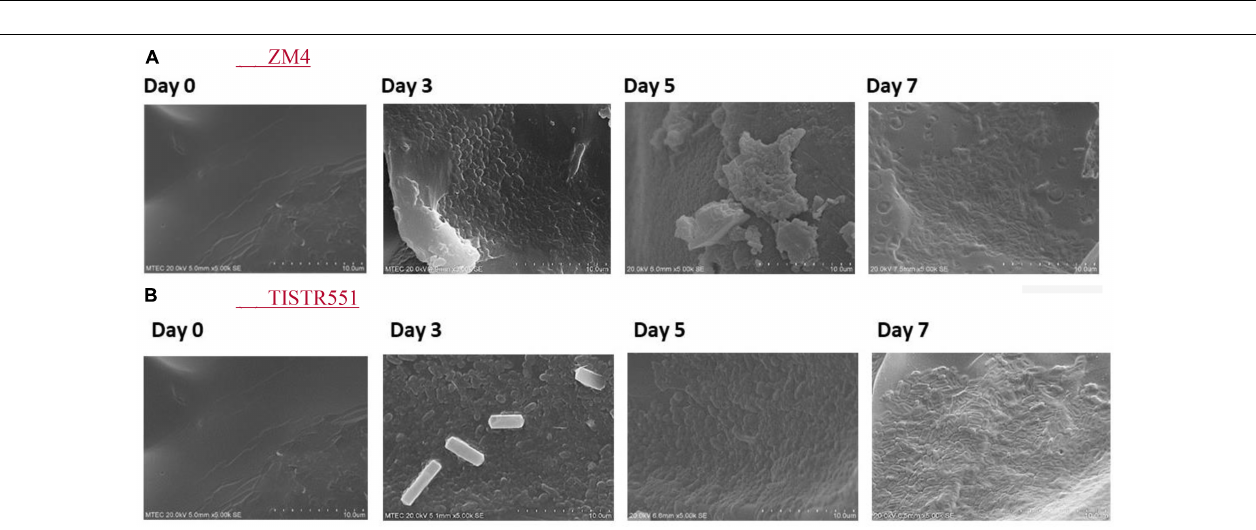
FIGURE 2 | Zymomonas mobilis ZM4 and TISTR551 biofilm development or bacterial attachment on GP110 plastic composited corn silk on days 0, 3, 5, and 7, based on the 1% w/v crystal violet staining assay were compare with the control. The experiment was performed in triplicate, and the average and SD were plotted among these experiments.